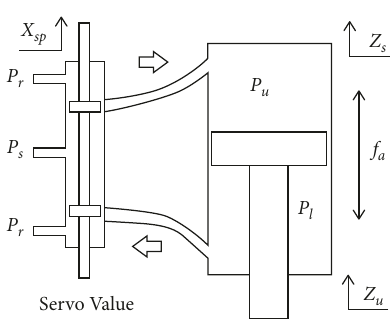
Figure 4: Hydraulic actuator system with double